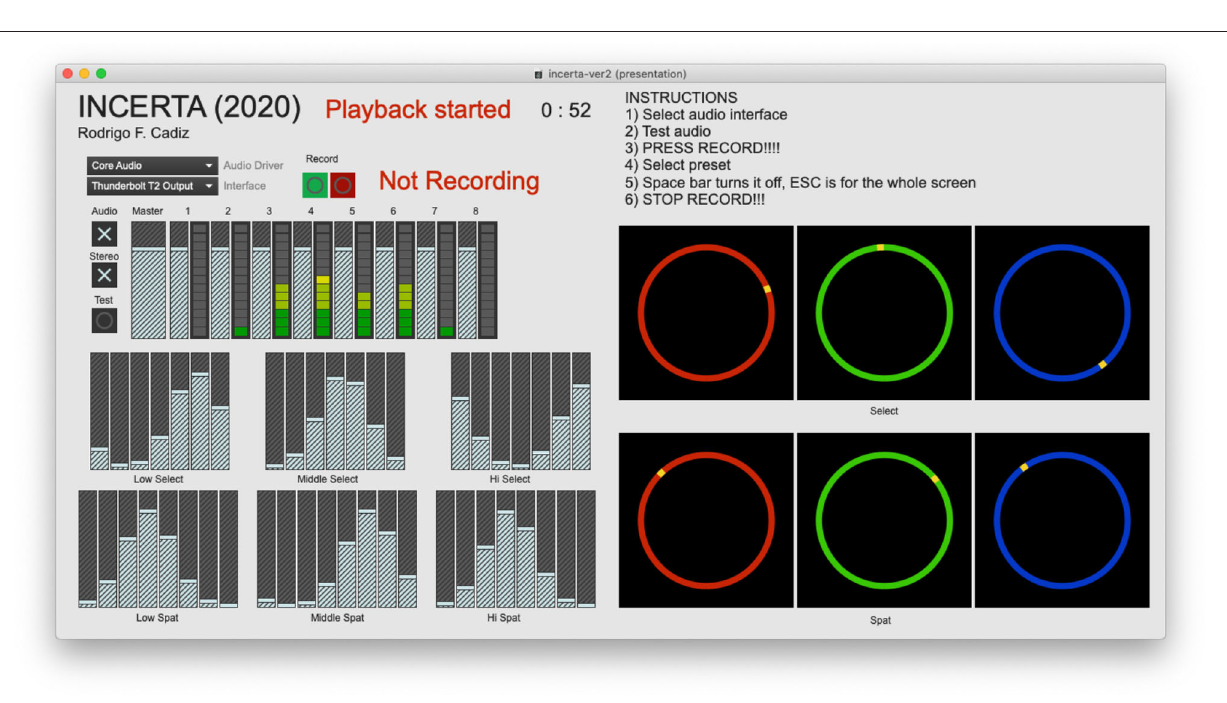
Frontiers in Artificial Intelligence |